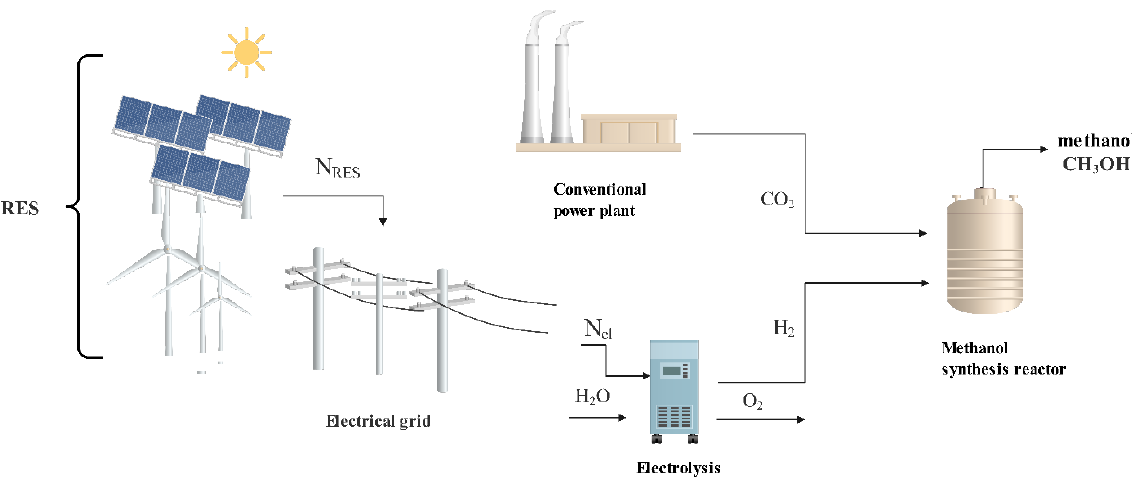
Figure 1. General scheme of the renewable methanol production concept.